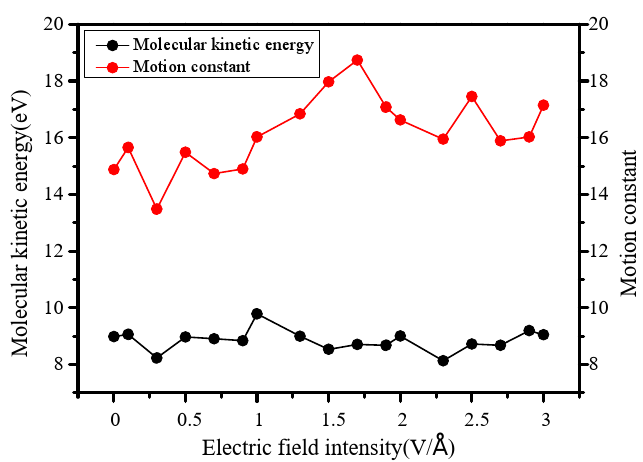
Figure 6. Changes of kinetic energy and motion.